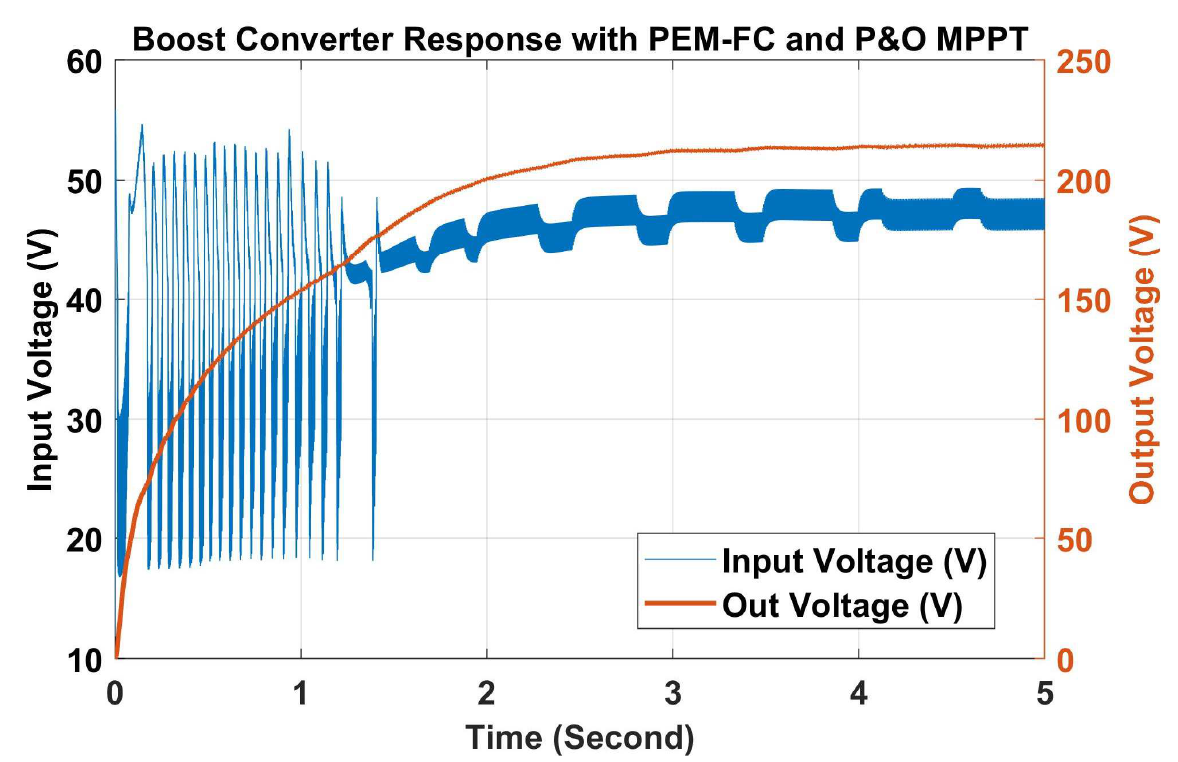
Figure 10. Input and Output Voltage of Boost Converter with PEM-FC and P-&-O MPPT.